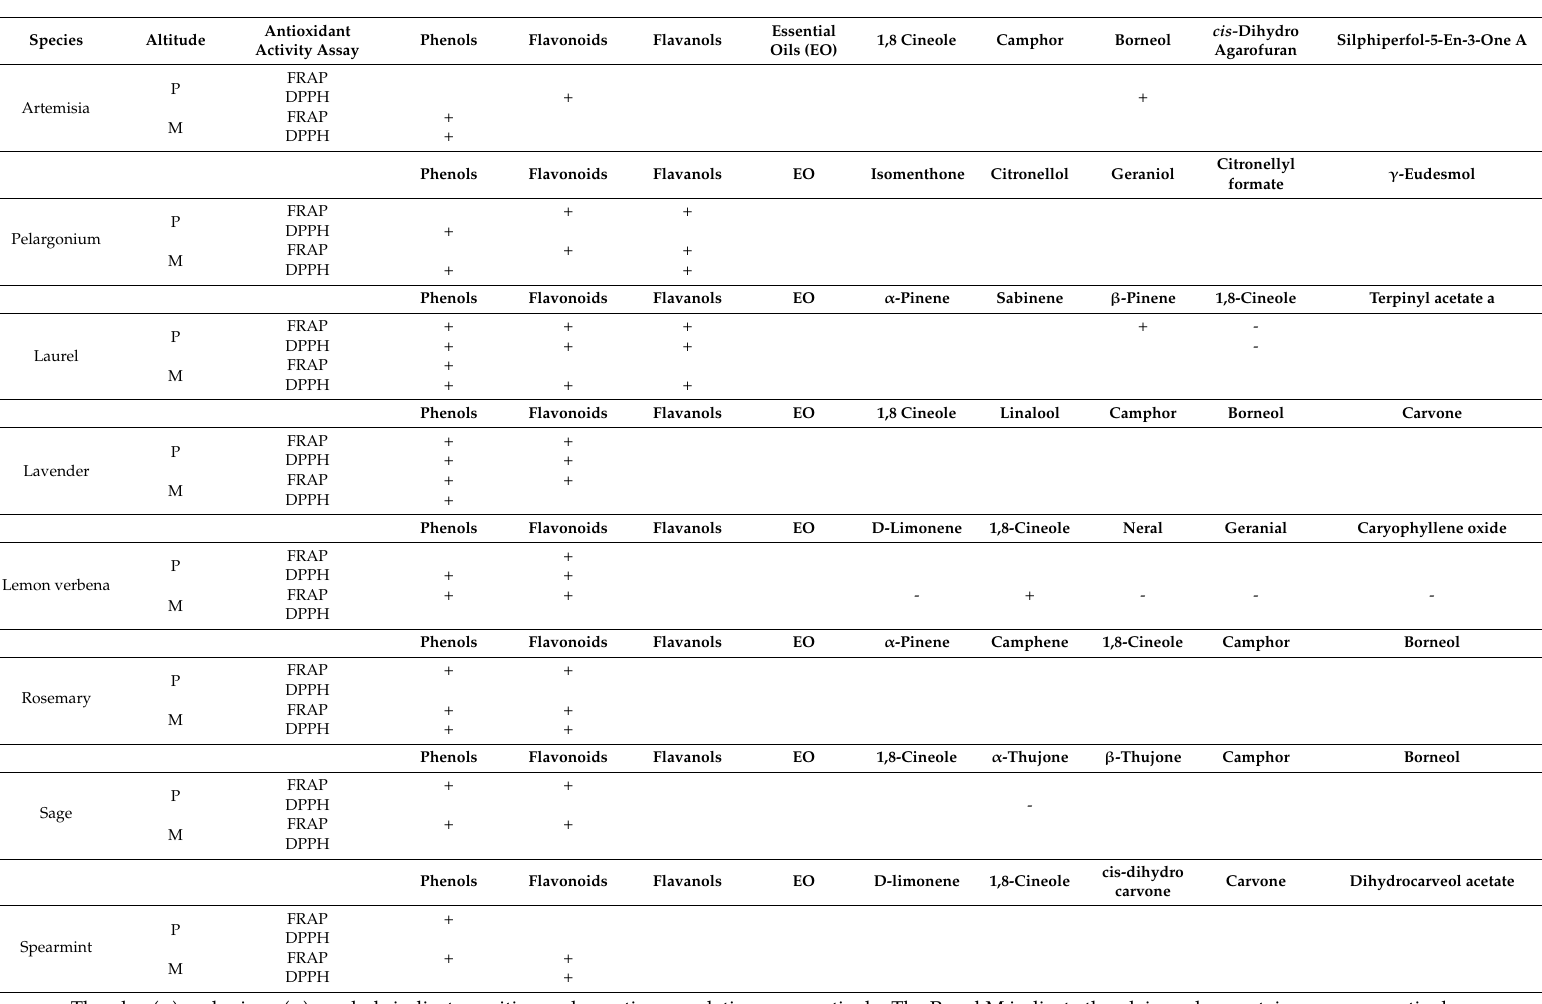
Table 11. Correlations between antioxidant activity, phenolic compounds, and essential oil